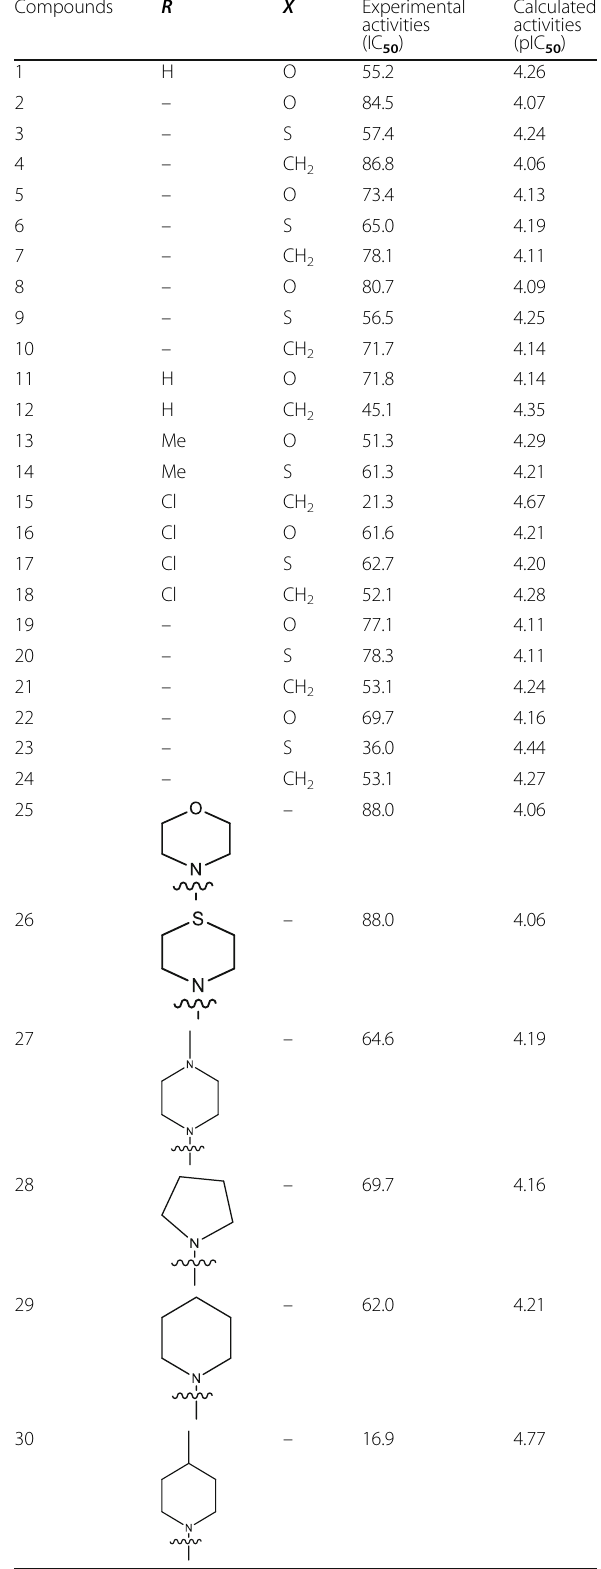
Table 1 2-Anilimopyrimidine derivatives with their activities Compounds